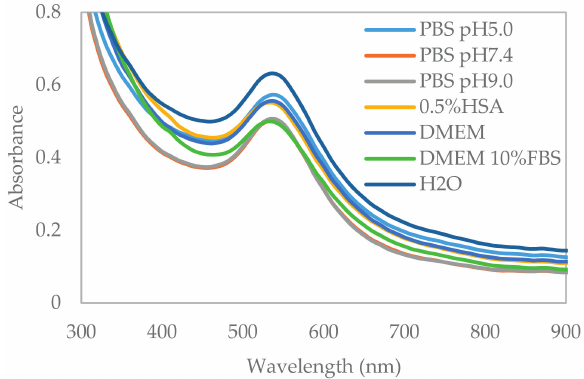
Figure 4. UV-Vis absorption spectra of AuNPs after 24 h of incubation in phosphate buffered saline (PBS) of pH 5.0, 7.4, 9.0, 0.5% human serum albumin (HSA), Dulbecco’s Modified Eagle Medium (DMEM), DMEM with 10% fetal bovine serum (FBS), and ultrapure water. Zeta potential values of AuNPs in ultrapure water were found to be − 38.2 ± 0.6 mV (Table 1). A slight decrease in zeta potential values ( − 26.4, − 29.2, − 33.3, and − 34.4 mV) were observed for AuNPs dispersed in PBS of pH 5, 7, 9, and 0.5% HSA. Meanwhile, AuNPs in DMEM media and DMEM with 10% FBS demonstrated significant decreases in zeta potential values to − 20.9 and − 13.5 mV,